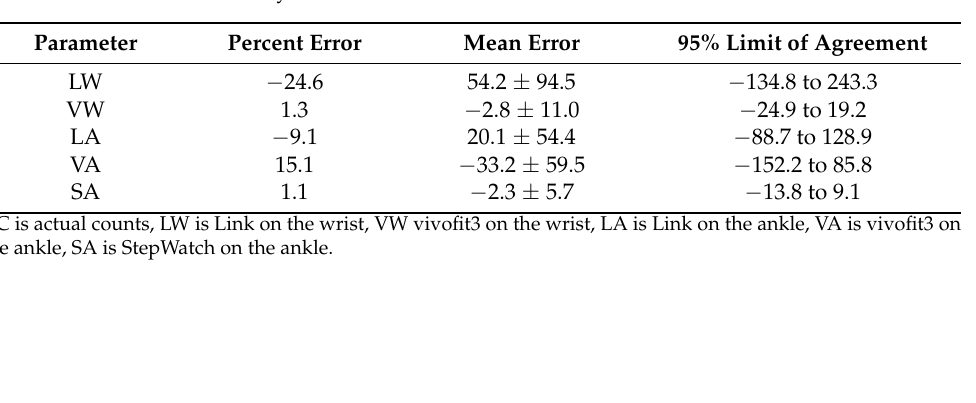
Table 5. Error scores of activity